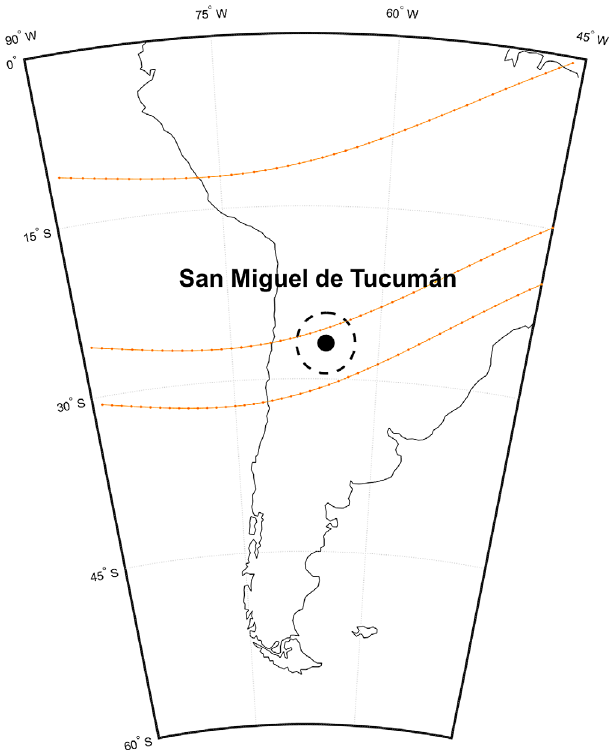
Fig. 1. Location (black dot) and fi eld of view at 350 km for 50 (cid:3) elevation (black dashed circle) of the GNSS receiver in San Miguel de Tucumán. Orange lines represent the expected position of the dip-equator on of the isoclinic lines at (cid:3) 15 (cid:3) and (cid:3) 20 (cid:3)